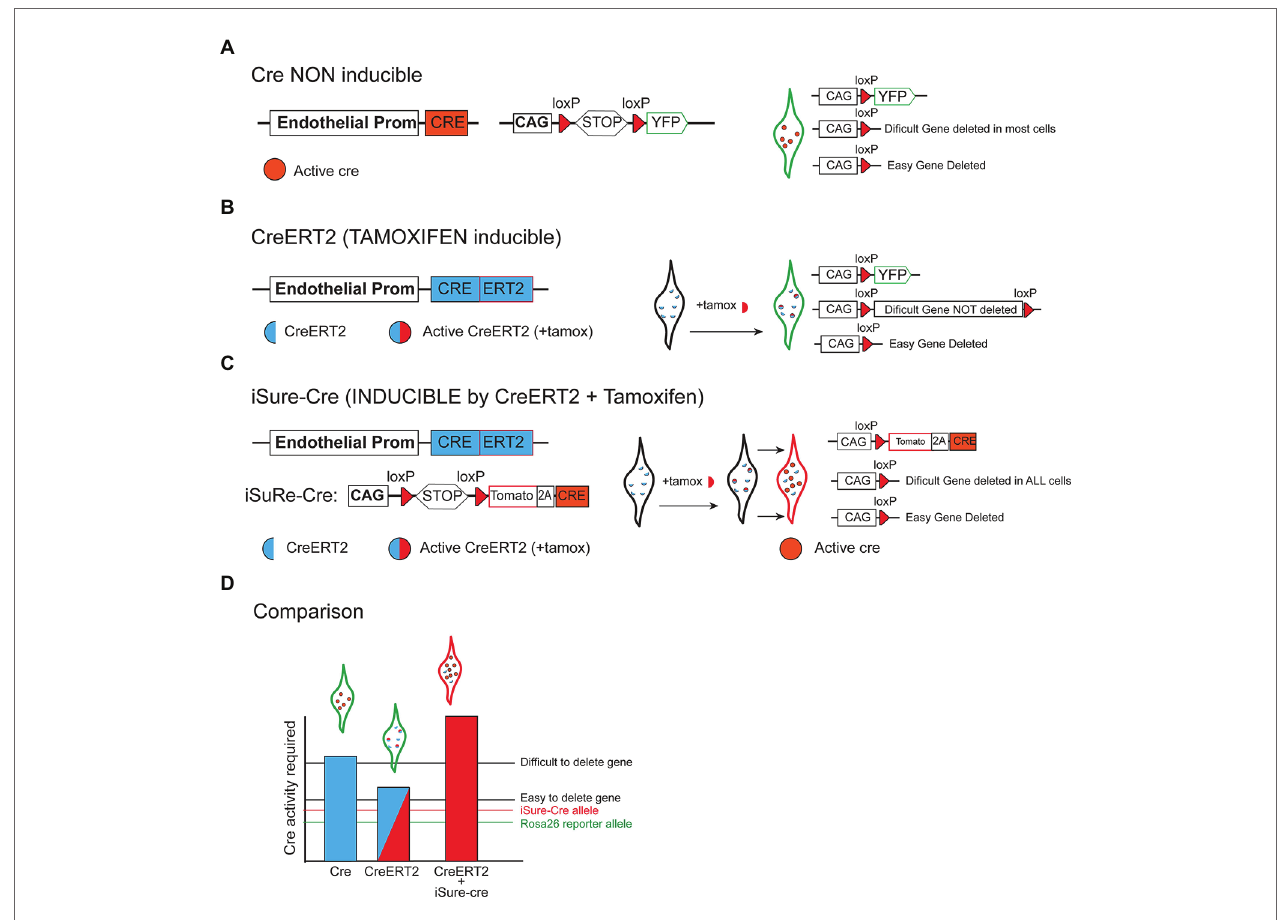
FIGURE 3 | Different strategies to delete floxed genes. (A) Scheme showing that when a constitutively active Cre allele (non inducible) is combined with a reporter allele, most cells expressing the reporter recombine/delete both easy and difficult floxed genes. (B) When tamoxifen-inducible CreERT2 alleles are used, many cells expressing the Cre-reporter allele may not delete other genes that are more difficult to delete since these require a higher or sustained level of recombinase activity. (C) The iSure-Cre allele is inducible by CreERT2, and enables a higher Cre activity in reporter-expressing cells. The use of this strategy guarantees full deletion of floxed genes in reporter-expressing cells. (D) Illustrative chart comparing the genetic strategies mentioned above. The bars represent the Cre activity achieved with most Cre/CreERT2 lines and the iSuRe-Cre allele. Different floxed genes require a different level of Cre activity to be deleted (an easy and difficult to delete gene is represented). Only the iSuRe-Cre allele can ensure the deletion of most genes in reporter-expressing